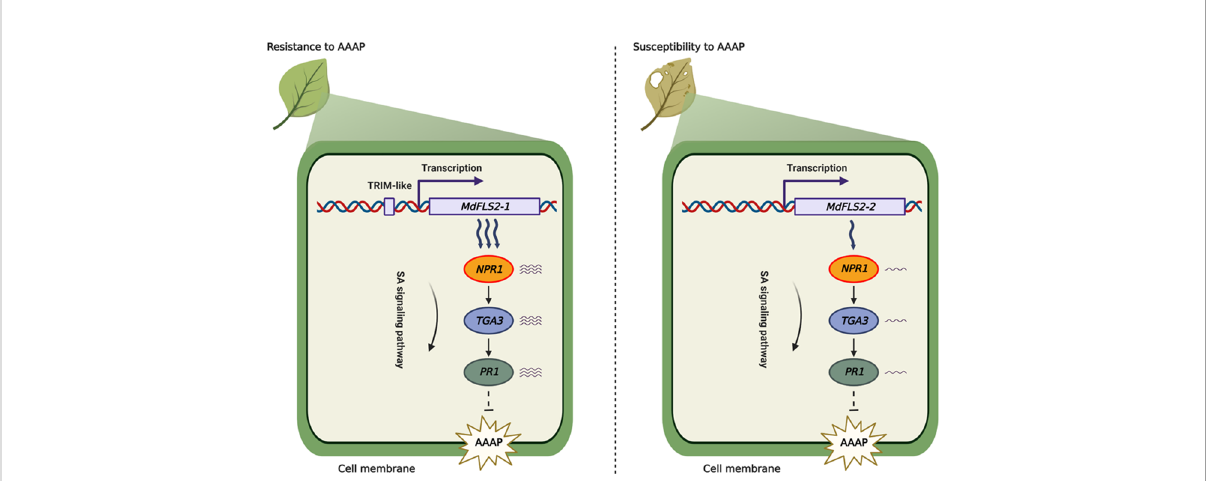
FIGURE 8 Model for the role of a TRIM-like sequence insertion in the MdFLS2-1 promoter region in regulating resistance of apple to Alternaria blotch disease. MdFLS2 allele is involved in the resistance of apple to Alternaria blotch disease via increasing the expression level of genes related to salicylic acid pathway ( NPR1 , TGA3 , and PR1 ). Insertion of a TRIM-like sequence into the MdFLS2-1 promoter region enhances MdFLS2-1 expression to improve resistance of apple to Alternaria blotch disease. Arrow: activation; Bar: